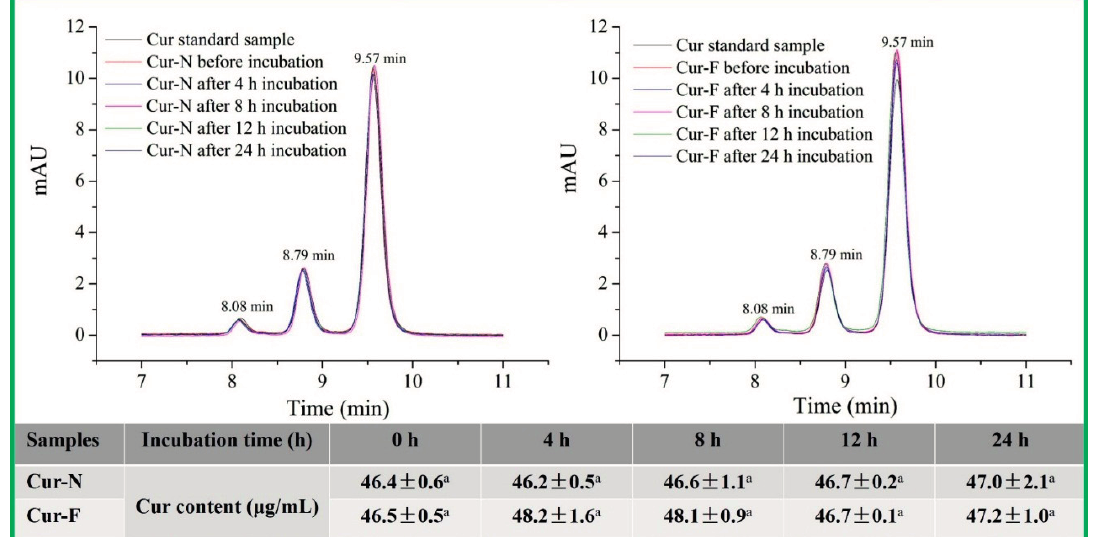
Figure 4. Structural integrity of curcumin under in vitro release conditions, Cur, Cur-F and Cur-N represent curcumin, free curcumin and curcumin nanoliposomes,